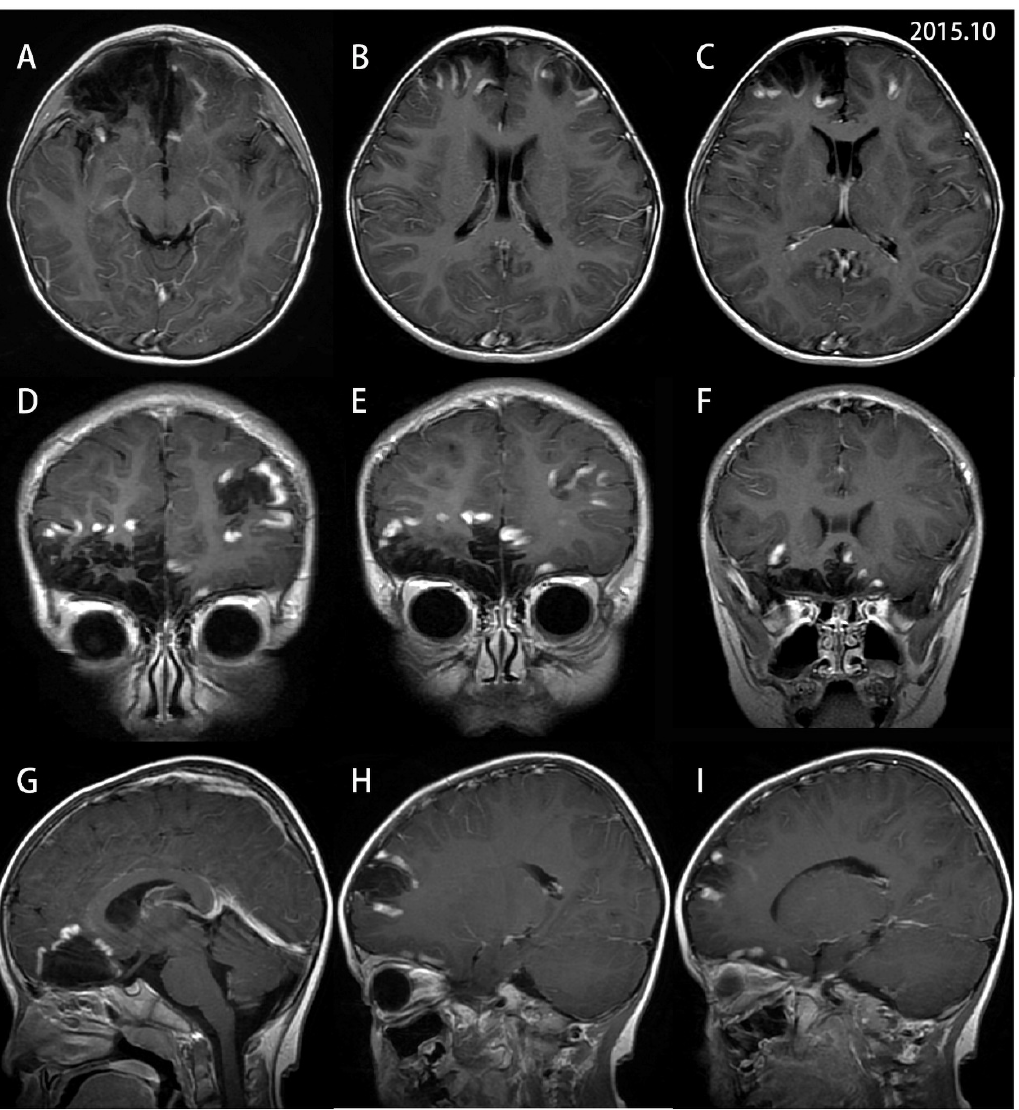
Figure 2. Gd-enhanced T1-weighted MRIs of the patient were performed during the initial acute attack in October 2015. Axial ( A – C ), coronal ( D – F ) and sagittal ( G – I ) images show multiple enhanced lesions restricted around the previous lesions or districts of encephalomalacia, which were revealed with lace-like enhancement.